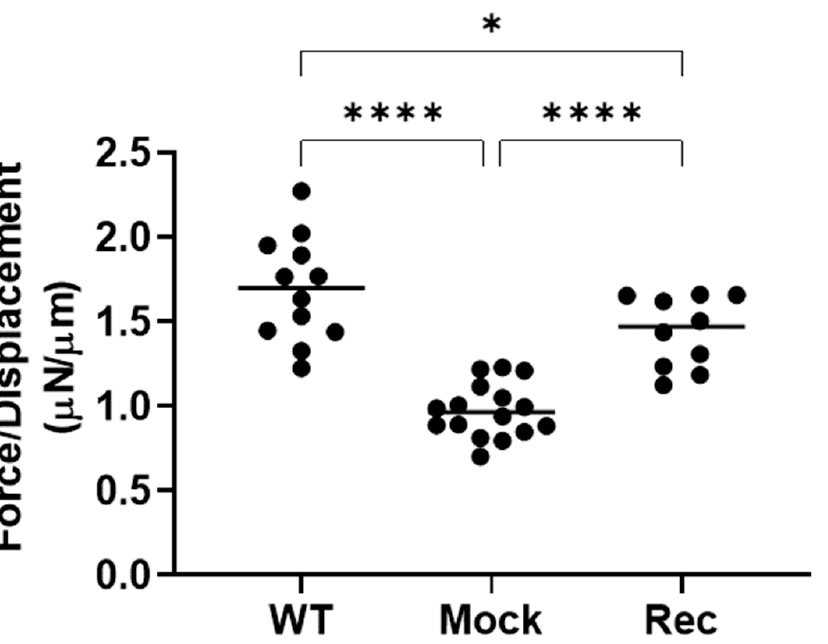
Figure 4. The stiffness of the 3D spheroids of WT, A549 MOCK and A549 Rec were measured at Day 6 using a micro-squeezer, as described in the Methods section. The force ( μ N) required to compress a single spheroid to the semidiameter ( μ N/ μ m) within 20 s are plotted. Experiments were repeated in triplicate using fresh preparations (n = 10 spheroids each). All data are expressed as the mean ± the standard error of the mean (SEM). Statistical significance was evaluated by ANOVA followed by a Turkey’s multiple comparison test (* p < 0.05, **** p < 0.001).